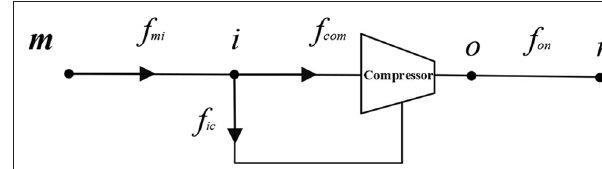
FIGURE 2 | Pipeline containing a compressor.